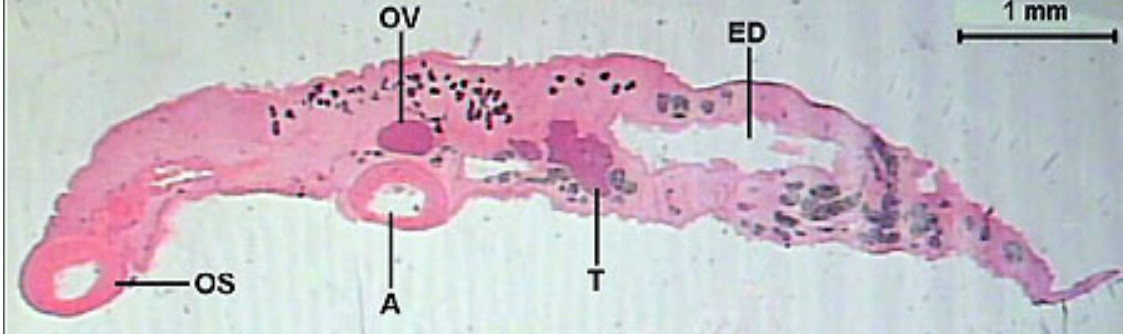
Figure 1. Longitudinal section of Sticholecitha serpentis . OV – ovary, ED – excretry duct, T – testicle, A – acetabulum, OS – oral sucker.